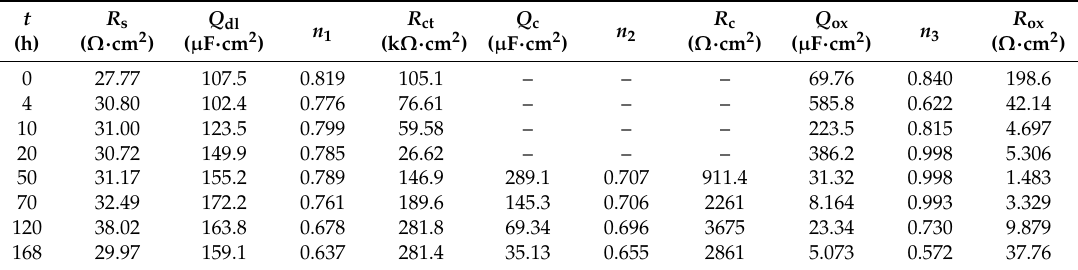
Table 2. Fitting parameters for EIS spectra of 304 SS under polarization at − 0.65